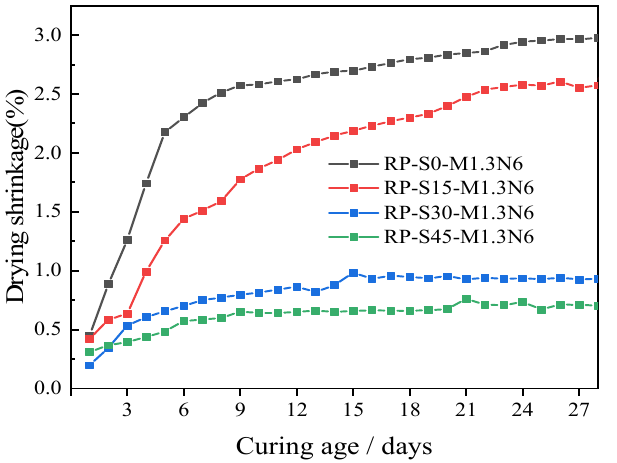
Figure 5. Drying shrinkage results of RPSG with different slag contents.